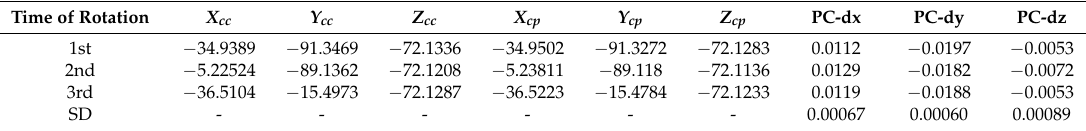
Table 6. Offsets from the CCs to the TPs with basic calculation (unit: mm).